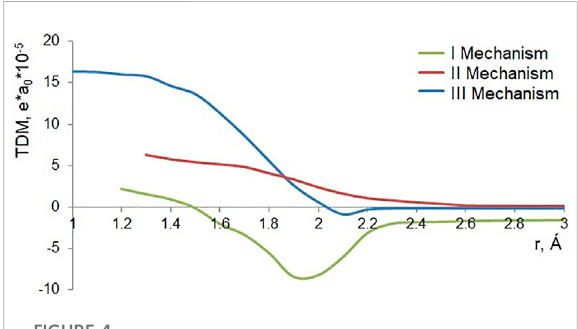
FIGURE 4 Transition dipole moment contributions of the 1 3 Σ − g → A 3 Σ + u band system of the N 2 molecule according to three mechanisms shown schematically in Figure